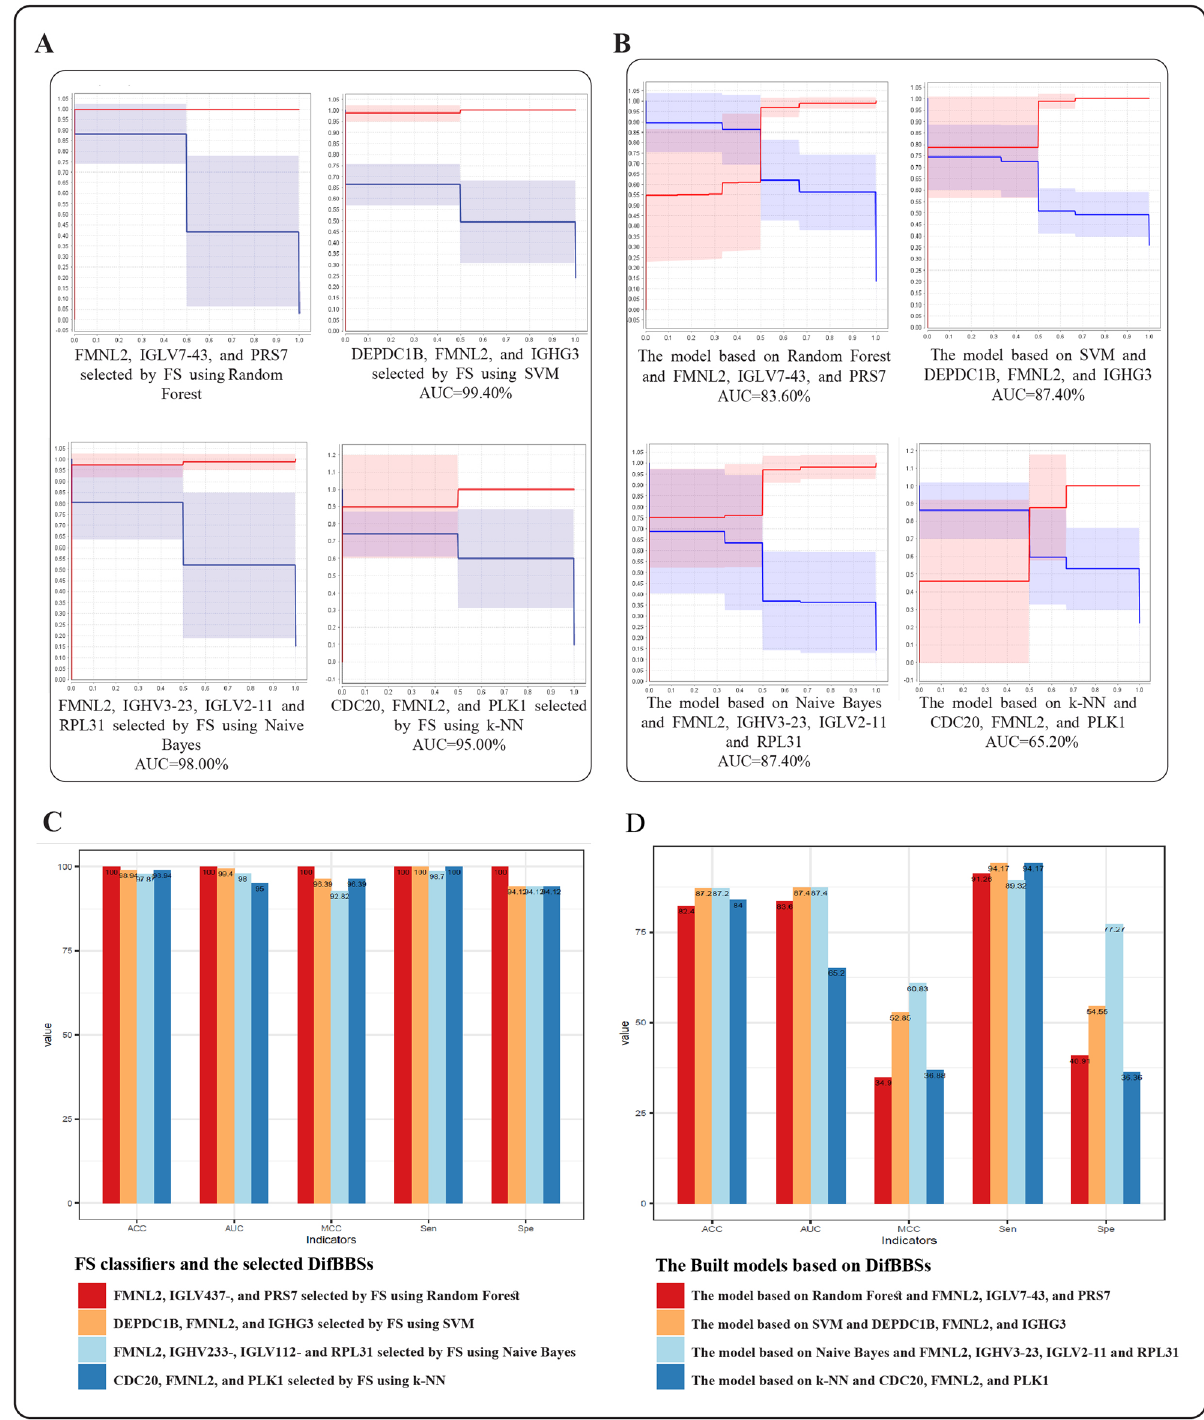
Figure 6. The ten-fold cross-validation results of the feature selection method in choosing DifBBSs and the constructed machine learning models; ( A ) ROC curves representing classification ability of the feature selection method by the four classifiers on GSE161731-B dataset (the feature selection dataset); ( B ) ROC curves representing classification powers of the constructed models based on the selected DifBBSs and corresponding algorithms (the same algorithms that were applied in feature selection step) on Bibert et al.’s dataset-B (the validation dataset). These ROC curves show ROC (red lines) at various threshold settings (blue lines). In the ROC curves, the x-axis shows 1-specificity, and the y-axis shows sensitivity. ( C ) Four measures indicating the classification power of the feature selection method by the four classifiers on GSE161731-B dataset (the feature selection dataset); ( D ) Four measures indicating the power of constructed models based on the selected DifBBSs and the corresponding algorithms (the same algorithms that were applied in feature selection step) on Bibert et al.’s dataset B (the validation dataset). FS: feature